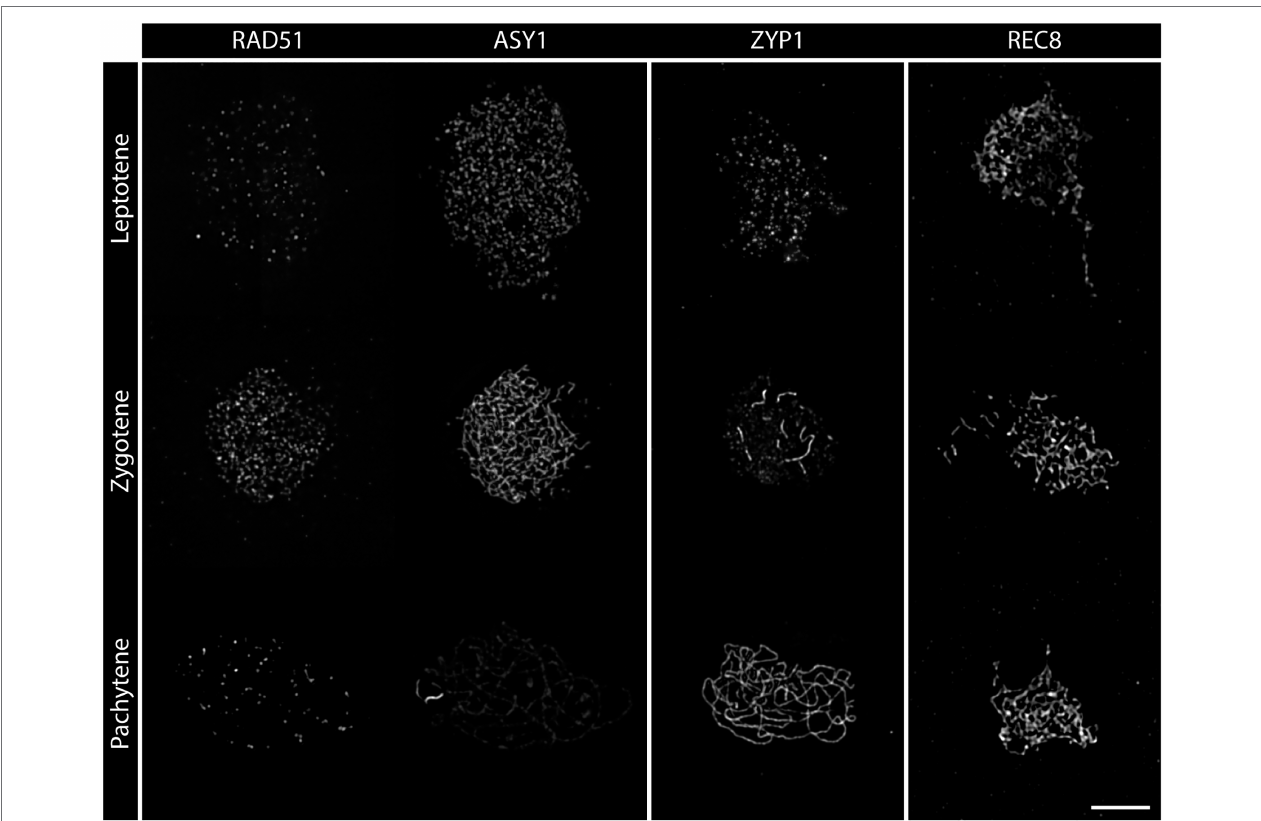
FIGURE 2 | Detergent-spread nuclei from PMCs depicting the meiotic progression from leptotene to pachytene in the wild-type. The spreads were stained for the recombinase RAD51, the axial element protein ASY1, the transverse filament protein ZYP1, or the meiosis-specific cohesin subunit REC8. Images were acquired with an epifluorescence microscope. Meiotic stages are indicated. Scale Bar: 5 μ